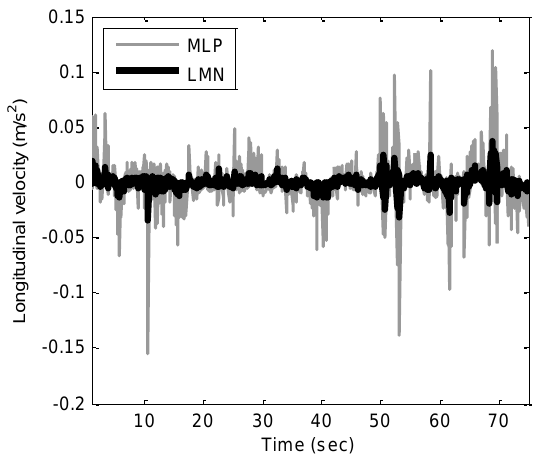
Figure 7. Estimated longitudinal velocity error.